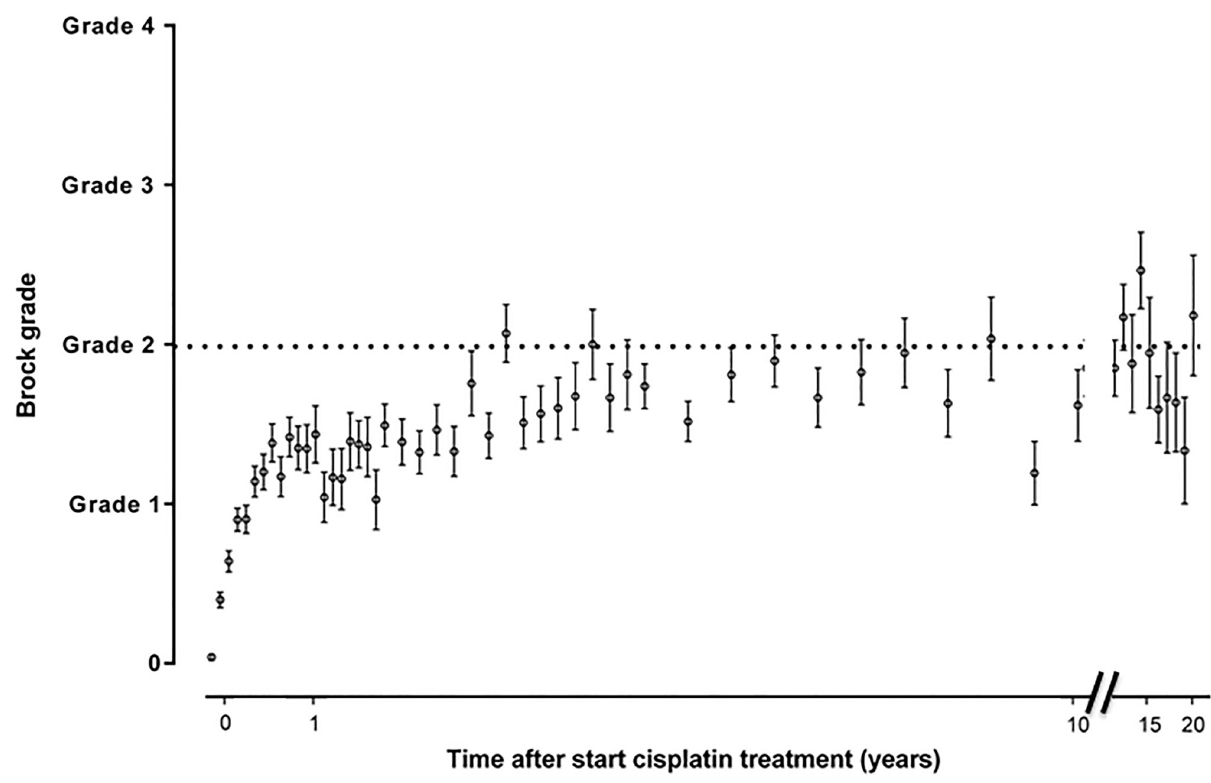
Fig 3. Progression of hearing loss based on Brock grade. The time after start cisplatin treatment in 654 patients is depicted on the x-axis and the hearing loss grade is depicted on the y-axis. The dots represent the mean and the whiskers represent the standard error of the mean ototoxicity grade. The dotted horizontal line depicts the cut-off for hearing loss